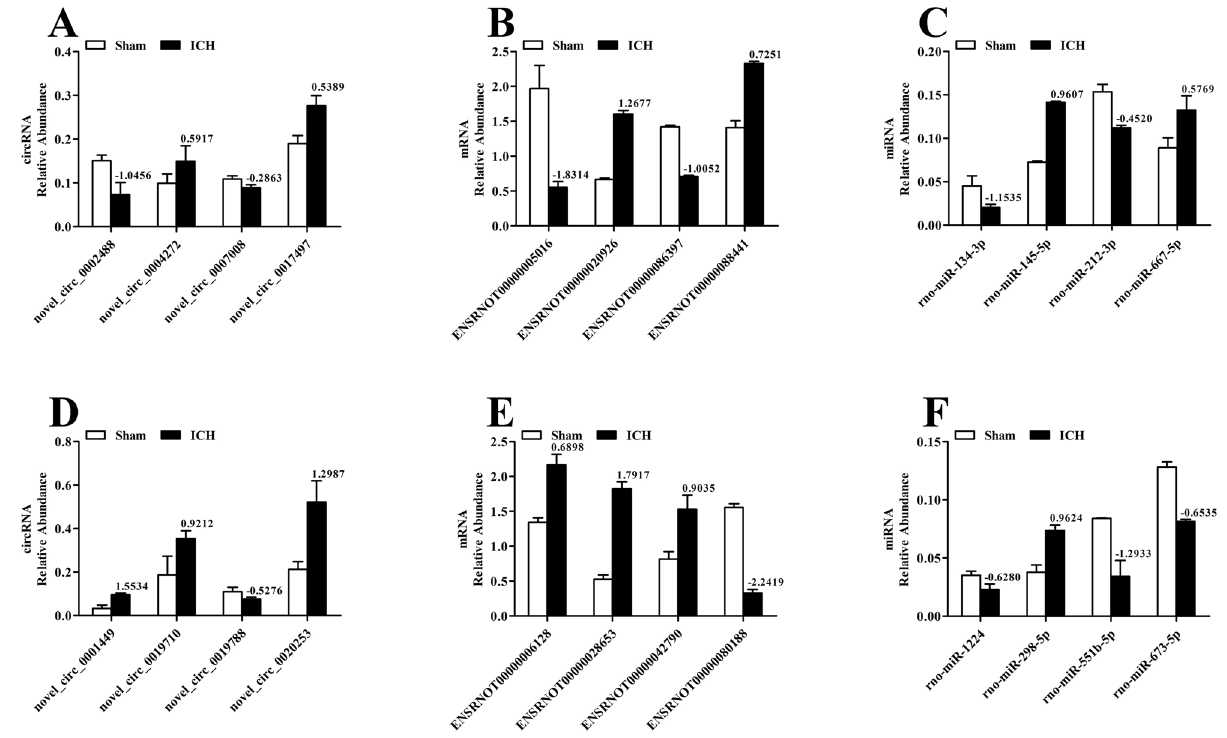
Figure 4. Validation of selected transcripts using qRT-PCR. ( A ) The expression and fold down or up changes (log 2 scaled) of selected day-7 circRNAs between ICH and Sham groups. ( B ) The expression and fold down or up changes (log 2 scaled) of selected day-7 mRNAs between ICH and Sham groups. ( C ) The expression and fold down or up changes (log 2 scaled) of selected day-7 miRNAs between ICH and Sham groups. ( D ) The expression and fold down or up changes (log 2 scaled) of selected day-28 circRNAs between ICH and Sham groups. ( E ) The expression and fold down or up changes (log 2 scaled) of selected day-28 mRNAs between ICH and Sham groups. ( F ) The expression and fold down or up changes (log 2 scaled) of selected day-28 miRNAs between ICH and Sham groups. N = 6 per group. The data were normalized using the “mean ±